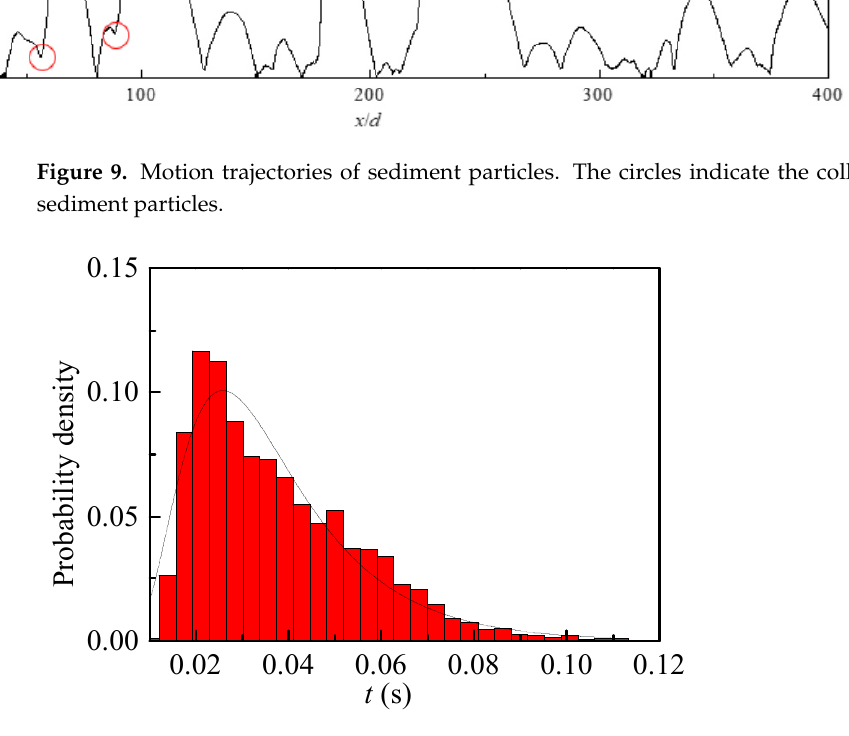
Figure 10. Probability density distribution of saltation time.